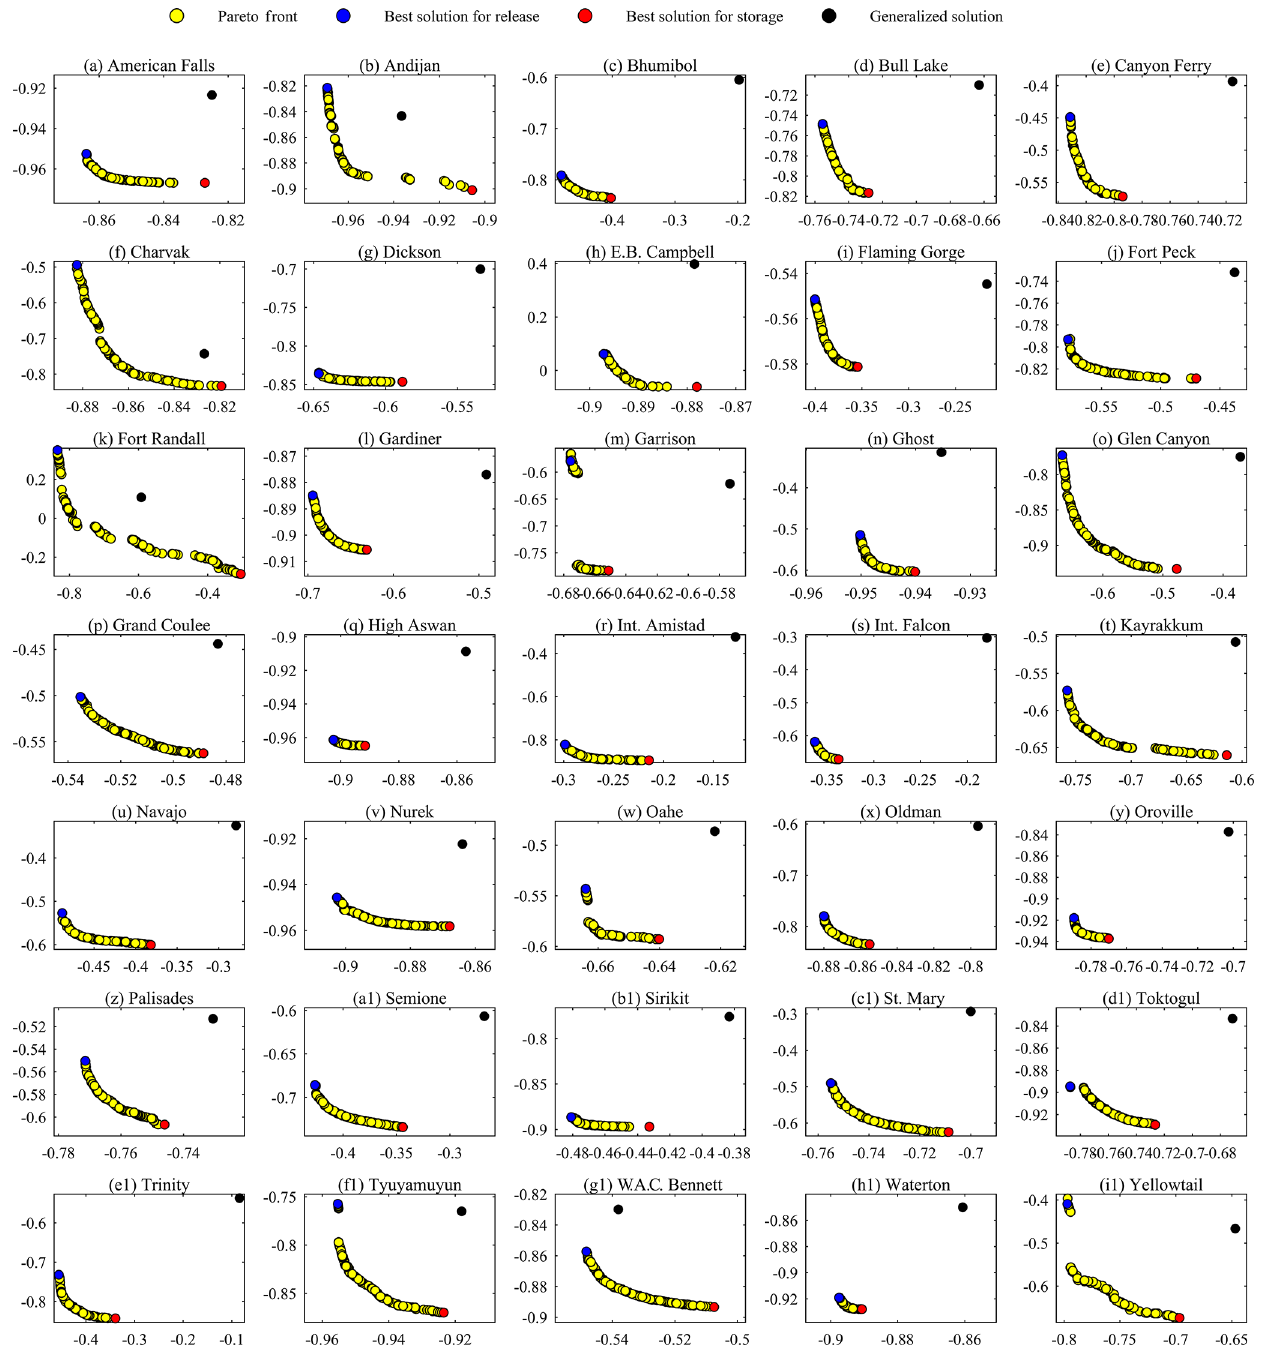
Figure 12. Reservoir-release-parameter multi-objective calibration using all available data for each reservoirs; x axes show NSE (flow) multiplied by − 1, and the y axes show NSE (storage) multiplied by −